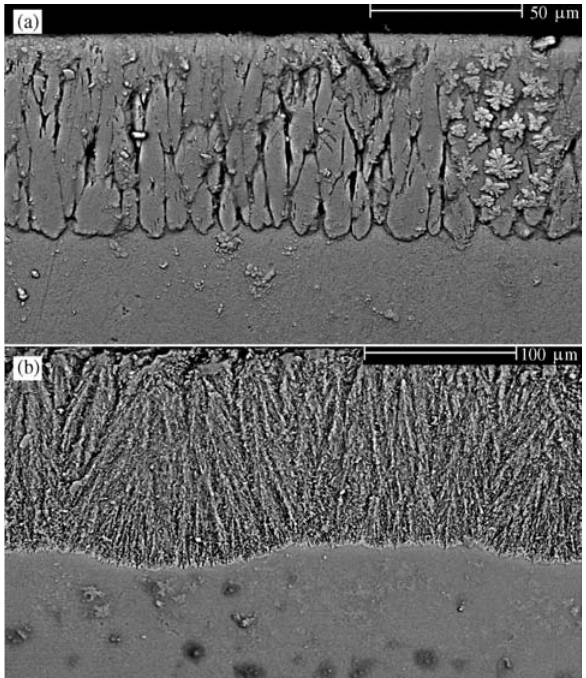
Figure 6. Micrograph of cross section of sample with 20% BaO submitted to thermal treatment.